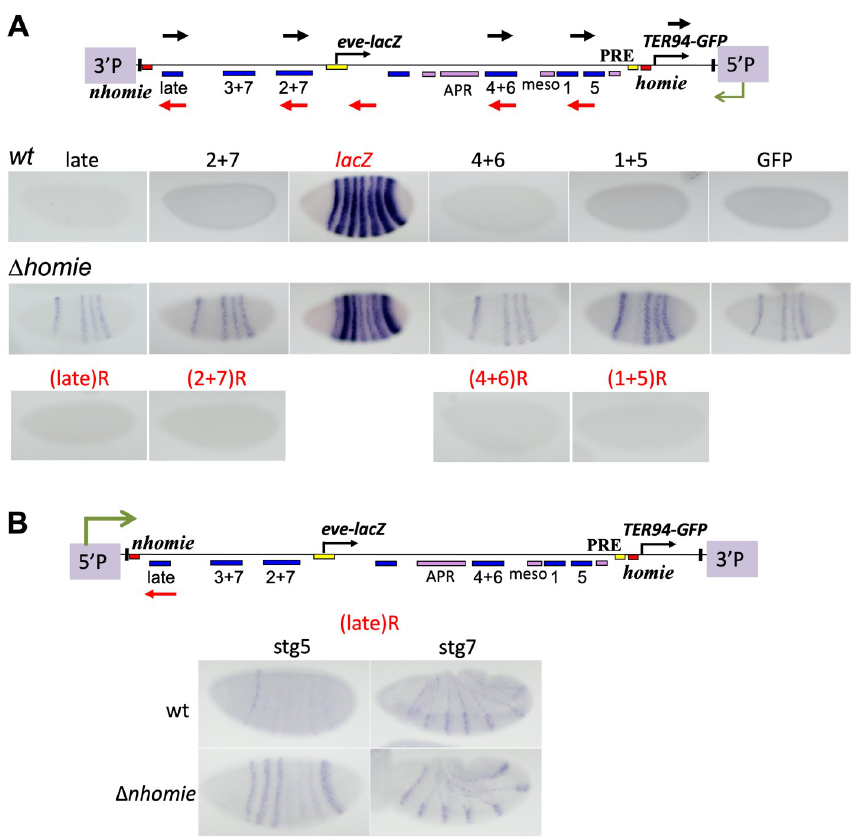
Fig 3. Patterns of non-coding RNA expression and eve promoter repression caused by insulator removal. RNA in situ hybridization to embryos carrying either the wt pseudo-locus, or Δ homie (in A), or Δ nhomie (in B). Probes are indicated with either black arrows, recognizing transcripts from downstream, or red arrows, recognizing transcripts from upstream. Images are labeled with either black lettering corresponding to black arrows, or red lettering (with ‘R’) corresponding to red arrows. Maps : Transgene constructs, showing location of the 5’ P-element end, where read- through transcripts are initiated. (A) Stage 5 embryos carrying the H5 orientation transgene at cytological location 74A2 (as in Fig 1B). Top row : wt embryos stained using the probes that recognize transcripts from downstream, where the P-element promoter is located ("late", "2+7", "4+6", "1+5", GFP). Middle row : Δ homie embryos, also stained using probes that recognize transcripts from downstream. Bottom row : Δ homie embryos stained using probes that recognize transcripts from upstream ("(late)R", "(2+7)R", "(4+6)R", "(1+5)R"). (B) Stage 5 and 7 embryos carrying either the wt (top row) or Δ nhomie transgene (bottom row) in the N5 orientation, at site 74A2 (used in Fig 1C). Transcripts coming from upstream, where the P-element promoter is located, are detected using probe (late)R (red arrow).